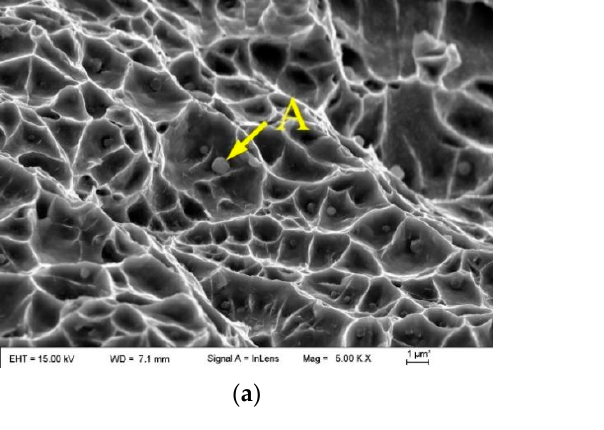
Figure 10. ( a ) SEM micromorphology of an area of dimples of impact fracture when arc length was 9.2 mm; ( b ) EDS analysis of point A in ( a ).